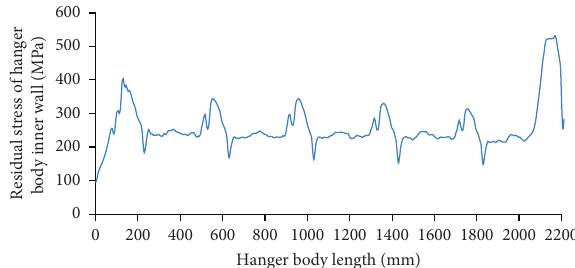
Figure 10: Residual stresses generated on the inner wall of the hanger body after